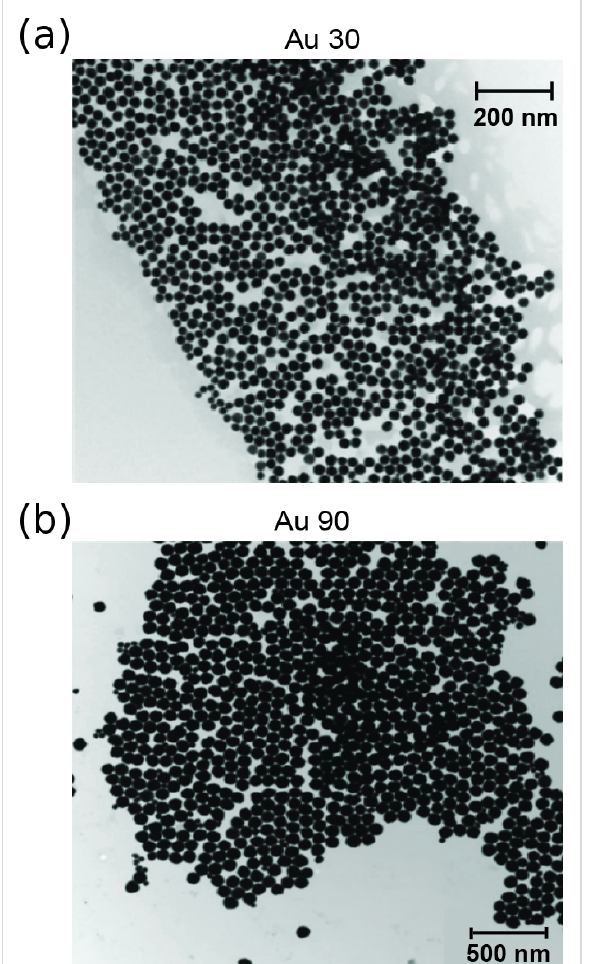
Figure 3: TEM images of spherical Au nanoparticles approximately (a) 30 nm in diameter and (b) 90 nm in diameter [37].